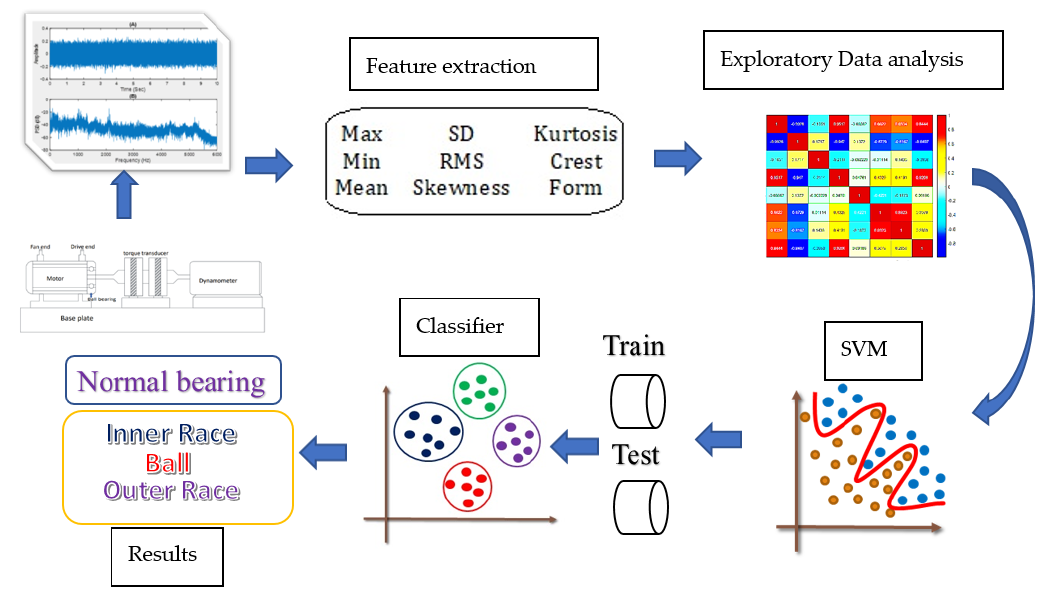
Figure 3. Flowchart to describe the SVM method.